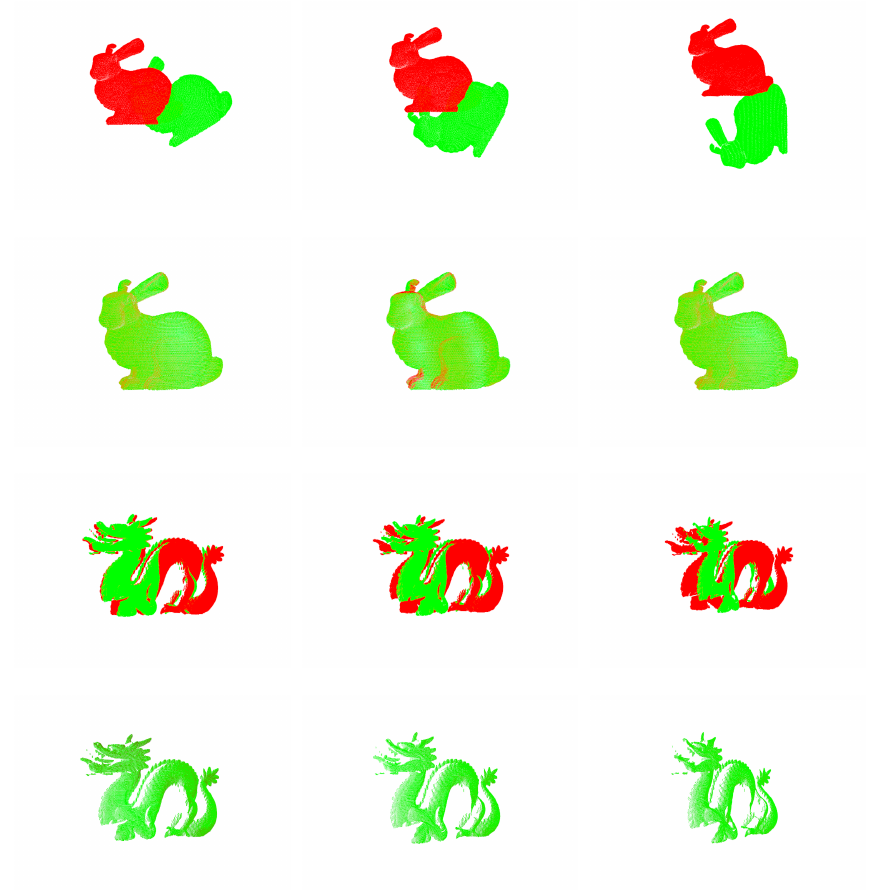
Figure 10. Visual registration results of the Bunny and Dragon models with different